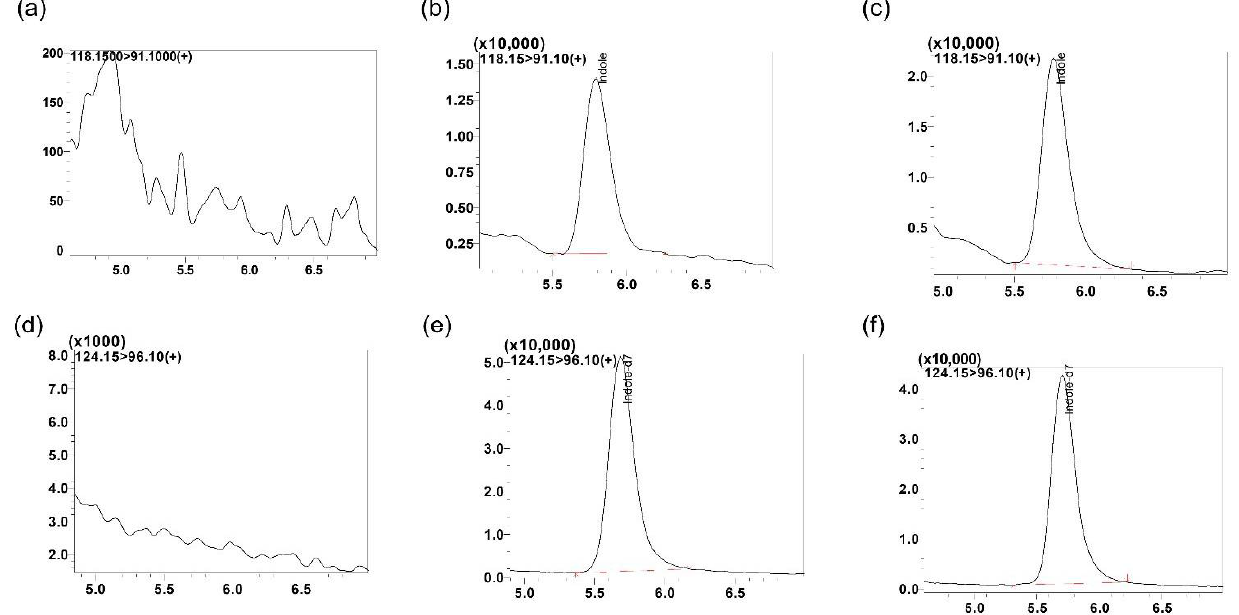
Figure 3. Representative MRM ion-chromatograms of ( a ) blank mouse serum using the conditions for indole detection, ( b ) indole spiked in mouse serum at 10 ng/mL (retention time, rt. 5.8 min), ( c ) indole mouse study serum sample (rt. 5.8 min, Id: AI-1_9-17-20), ( d ) blank mouse serum using the conditions for indole-d7 (IS) detection, ( e ) indole-d7 spiked in mouse serum (rt. 5.8 min, 200 ng/mL) and ( f ) indole-d7 spiked in mouse study serum sample (Id: AI-1_9-17-20).